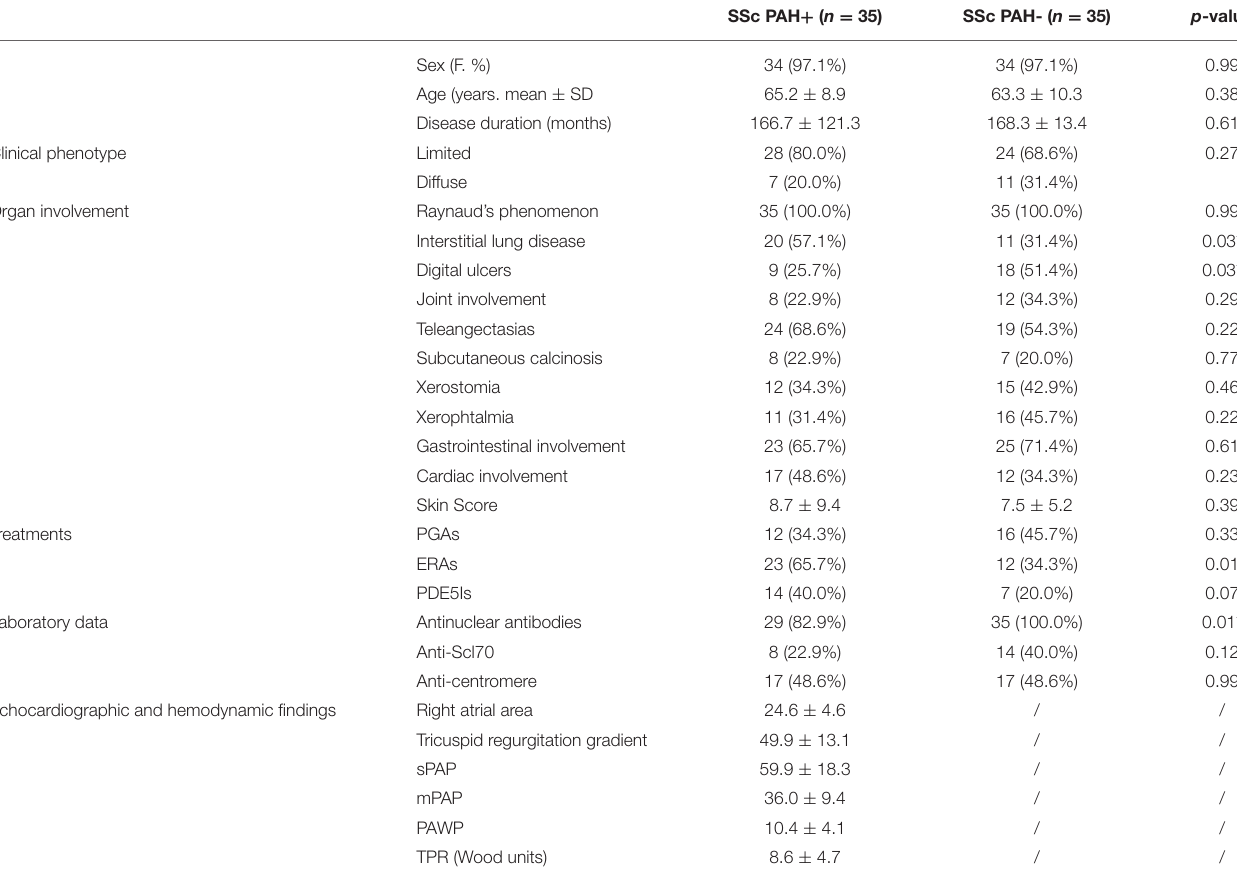
TABLE 1 | Demographic, clinical, laboratory and hemodynamic parameters of SSc patients, with and without pulmonary